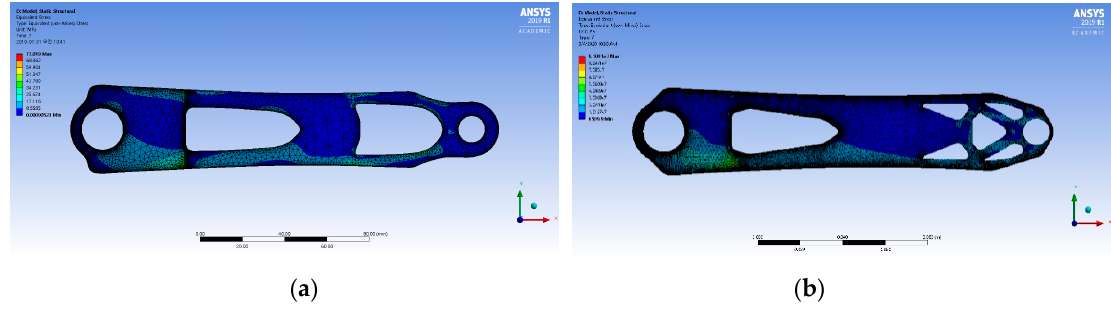
Figure 12 . Example of topological holes obtained with different mesh sizes (compliance minimization with 50% mass constraint): (a) Coarse mesh, (b) fine mesh.